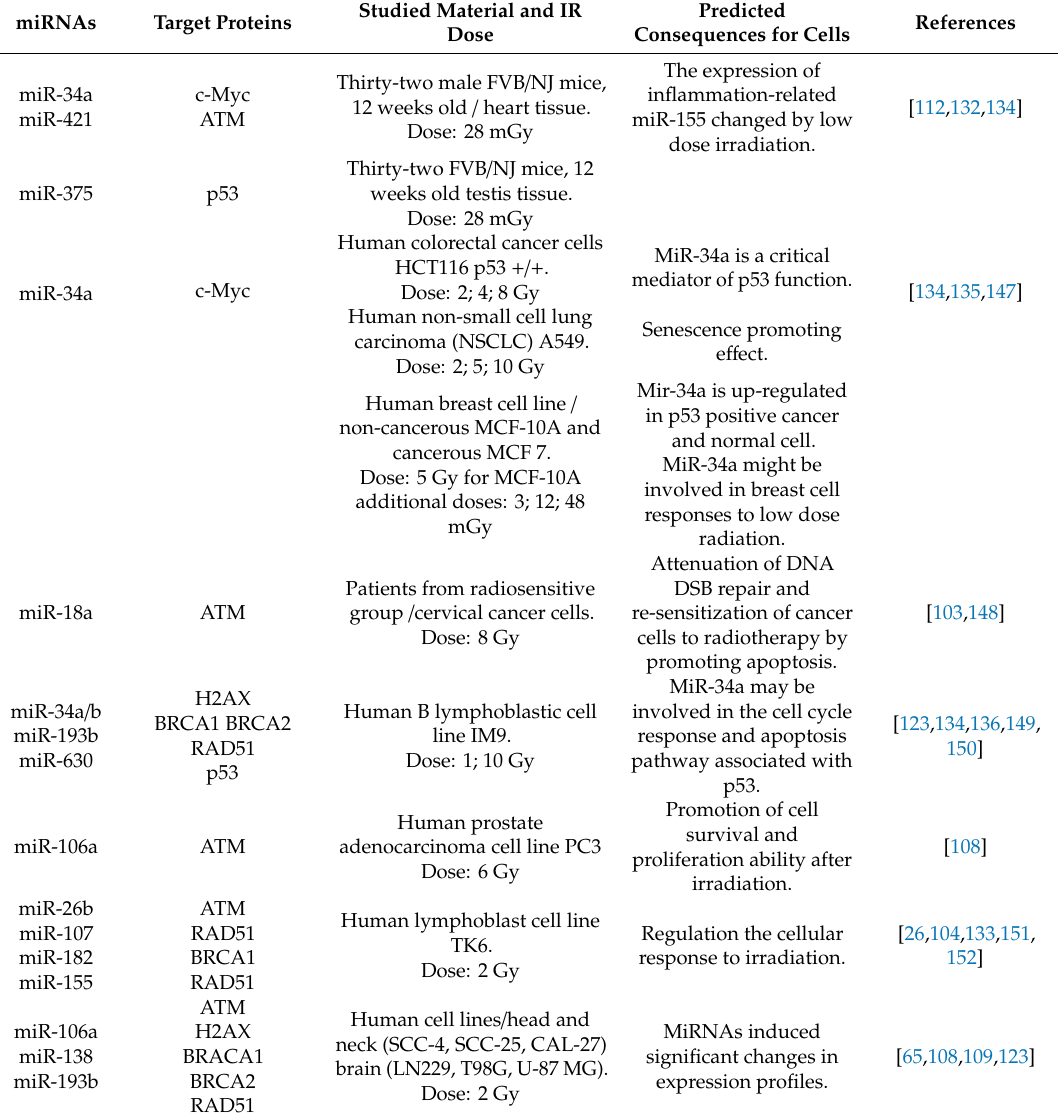
Table 2. MicroRNAs that a ff ect DNA damage response and homologous recombination repair upregulated after